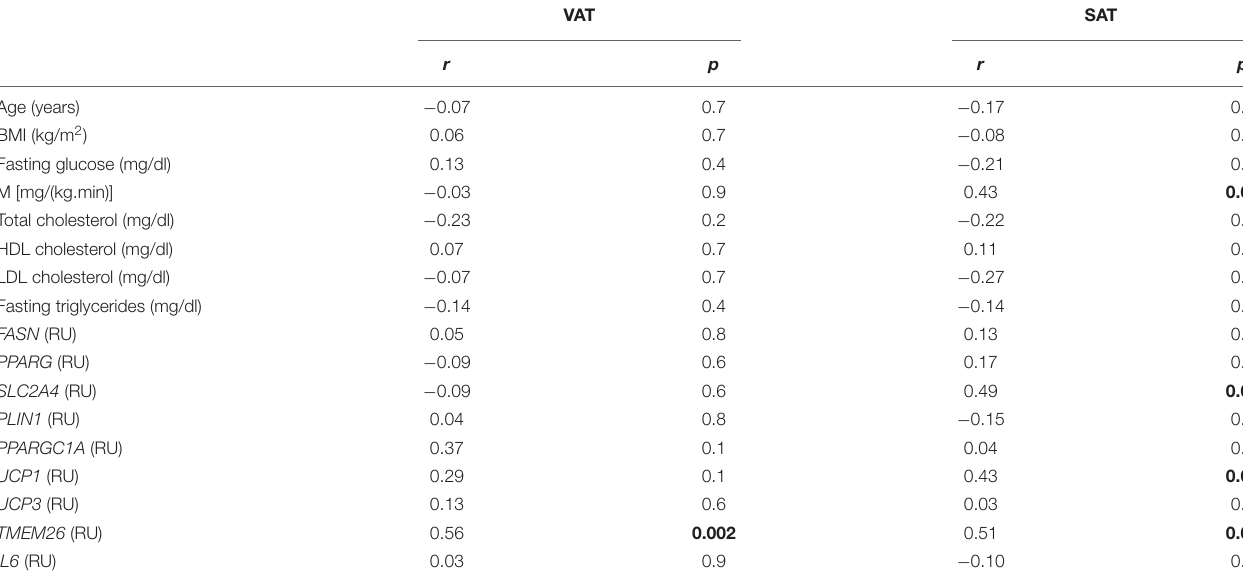
TABLE 5 | Correlation between NRG4 gene expression and anthropometric and clinical characteristics and selected gene expression in SAT ( n = 25) and VAT ( n = 34) from cohort 2. VAT SAT r p